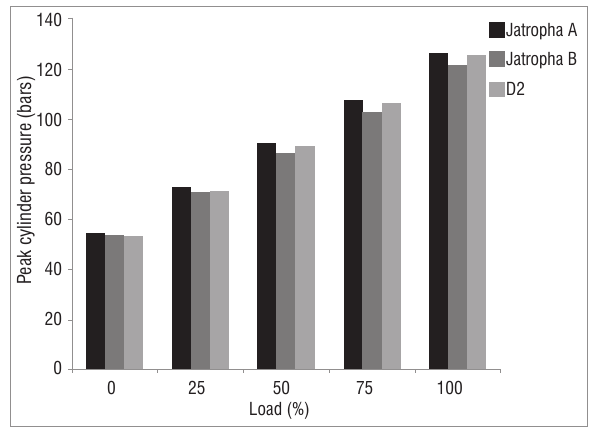
Figure 7: Peak cylinder pressure for the different fuel samples at different loads.